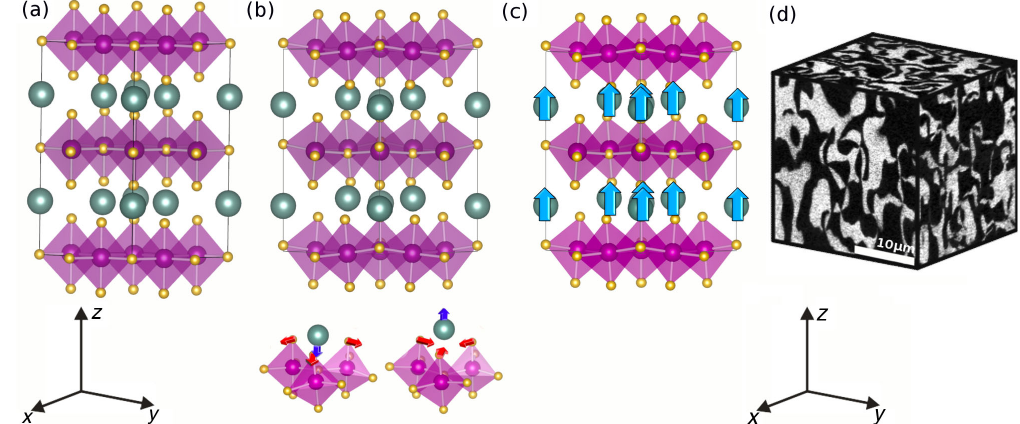
=mmc structure of R MnO FIG. 1. (a) High-symmetry P 6 before the onset of trimerization. (b) Action of the K trimerization mode 3 3 3 trigonal bipyramids. The insets below the image of the main structure emphasize that outward trimerization on the R ions and MnO 5 results in a downward shift of the corresponding R ion, whereas inward trimerization results in an upward shift. (c) The subsequent mode provide the ferroelectricity. Note that, once the orientation of the additional displacements of the R ions (blue arrows) in the (cid:1) (cid:2) 2 trimerization mode is set, the spontaneous polarization can emerge in only one direction. (d) Typical domain structure measured using piezoresponse force microscopy. The black and white regions correspond to opposite orientations of the ferroelectric polarization along the z axis. Note that the domain structure is isotropic, in spite of the layered crystal